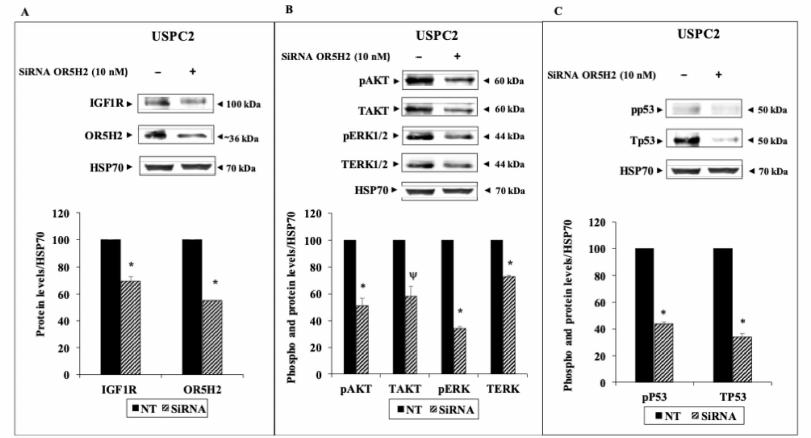
Figure 5. Effect of OR5H2 knockdown on downstream signaling proteins in USPC2 cells. USPC2 cells were transfected with 10 nM of OR5H2 siRNA (or non-targeting siRNA) for 48 h, after which cells were harvested and evaluated for IGF1R ( A ), phospho- and total-AKT and ERK ( B ), and total and phospho-p53 ( C ) levels. *, p < 0.01 versus respective control. Ψ p < 0.05 versus respective control.